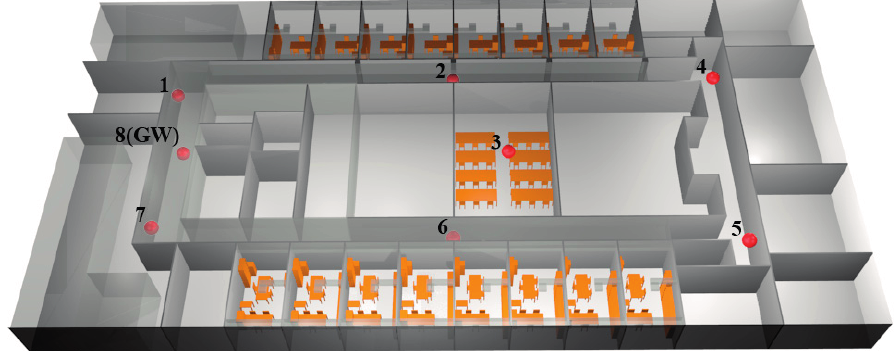
Figure 4. Schematic representation of the simulated scenario with the location of the antennas (represented by red points).